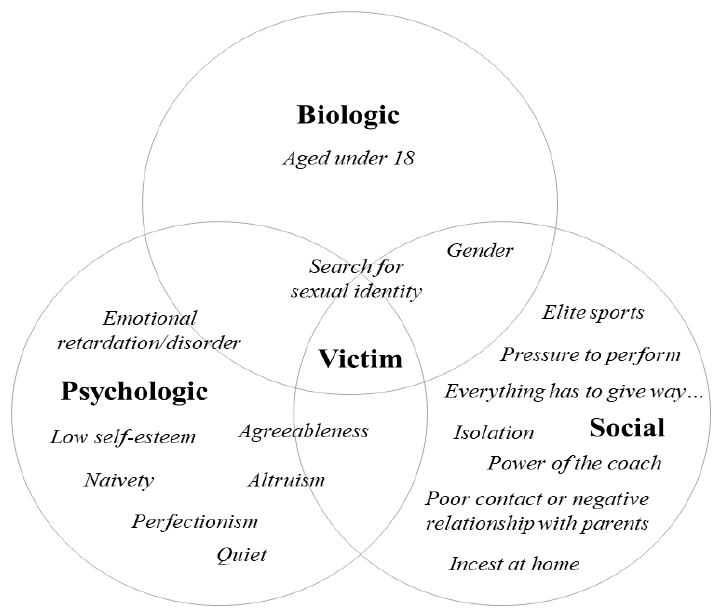
Figure 2. Schematic overview of possible biopsychosocial risk factors for experiencing SHA in sports, as determined from the current study.